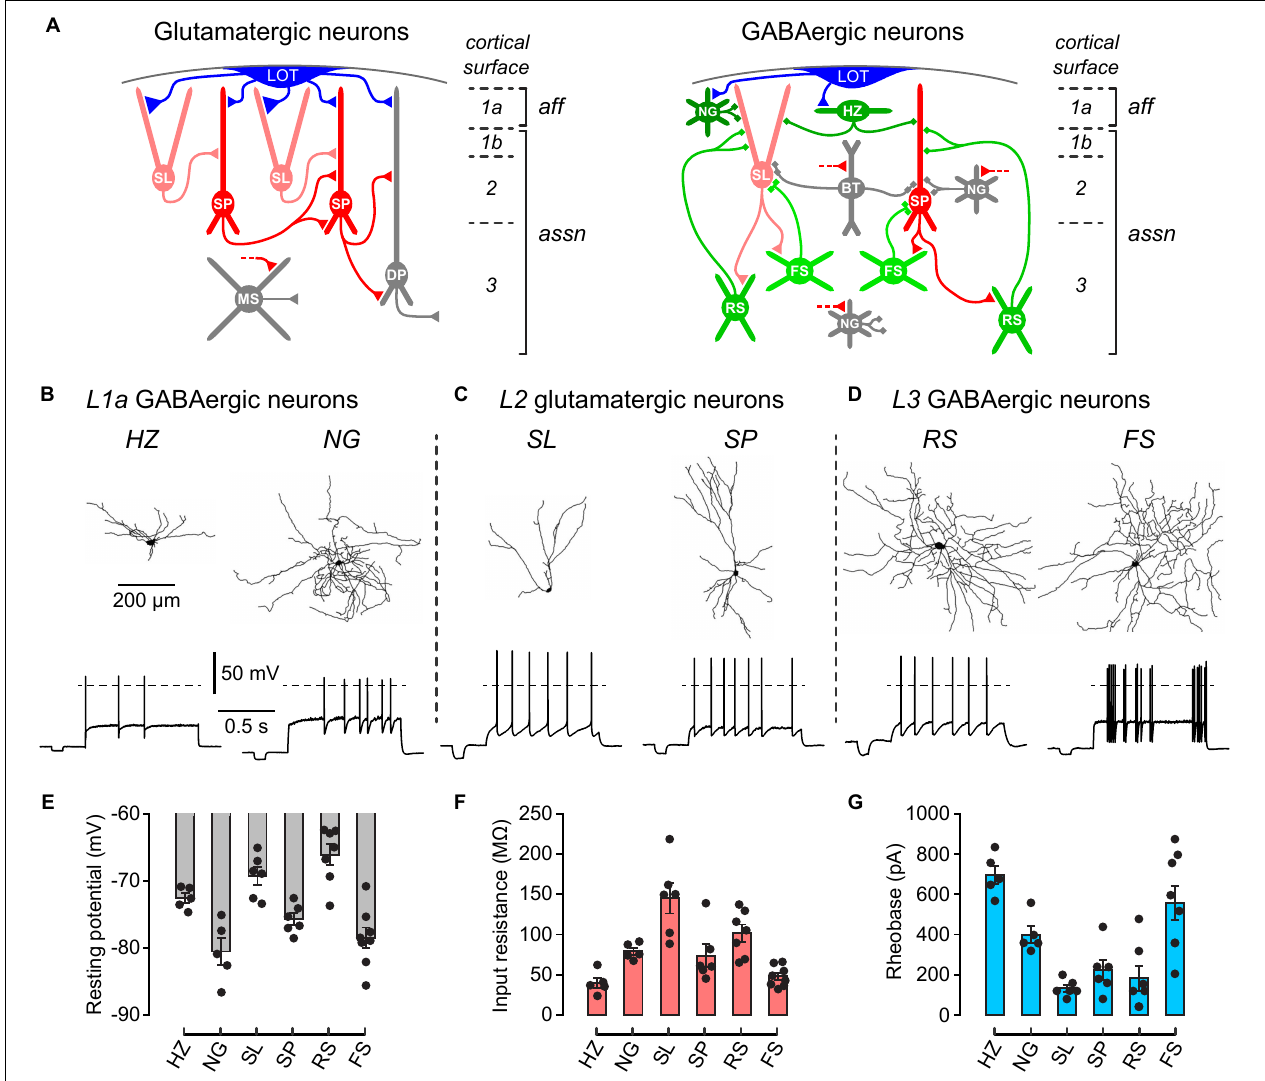
FIGURE 1 | Different types of neurons in the PCx can be differentiated by their laminar location, dendritic morphology and electrophysiological properties. (A) Schematic diagrams showing the main classes of glutamate-releasing excitatory neurons (red and gray, left) and GABA-releasing inhibitory interneurons (green and gray, right) in the PCx. A selection of inferred synaptic connections is also shown. Gray cells were not examined in this study. LOT, lateral olfactory tract; SL, semilunar; SP, superficial pyramidal; DP, deep pyramidal; MS, multipolar spiny; NG, neurogliaform; HZ, horizontal; BT, bitufted; RS, regular-spiking; FS, fast-spiking; aff , afferent layer; assn , associational layers. Modified from Bekkers and Suzuki (2013), used with permission. (B) Morphological and electrophysiological properties of GABAergic HZ and NG neurons in layer 1a ( L1a ) of the PCx. Reconstructed dendrites (top) and typical firing patterns just above rheobase (bottom) of an HZ cell (left) and an NG cell (right). Dashed horizontal lines represent 0 mV. Scale bars apply to the corresponding panels for all cell types. (C,D) Similar data for SL and SP glutamatergic neurons in layer 2, and RS and FS GABAergic neurons in layer 3, respectively. (E–G) Bar plots showing the mean resting potential, input resistance and rheobase ( ± SEM), respectively, for the 6 types of neurons shown above. Filled symbols are measurements from individual neurons. The n -values are: HZ, 5; NG, 5; SL, 6; SP, 6; RS, 7; FS, 8.